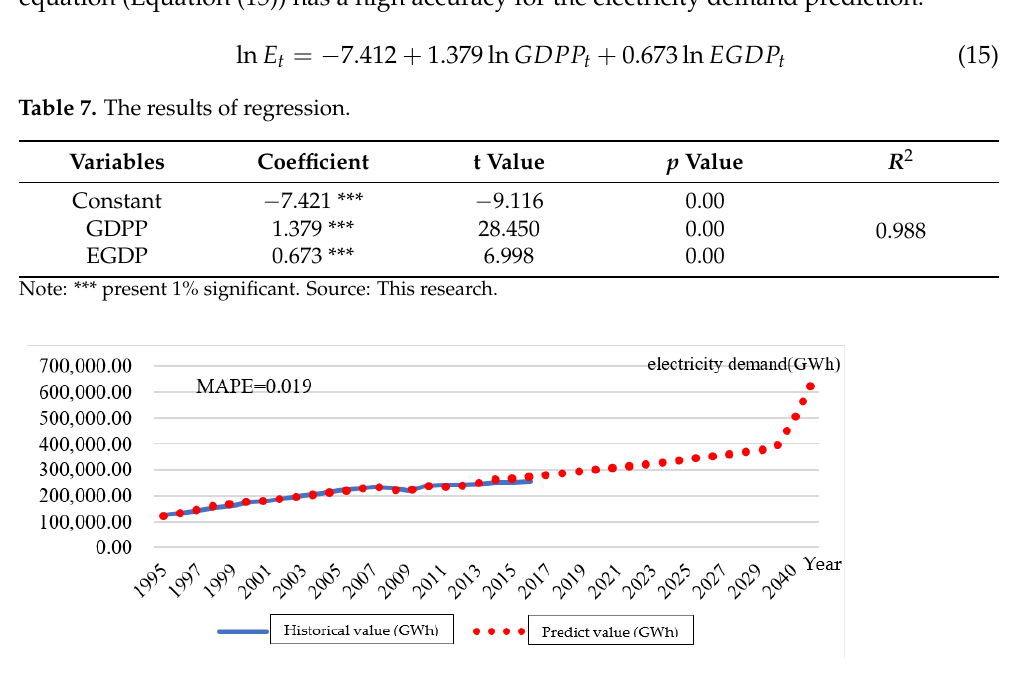
Figure 3. The MAPE (from 1998 – 2015) and electricity demand predict by 2050. Source: This